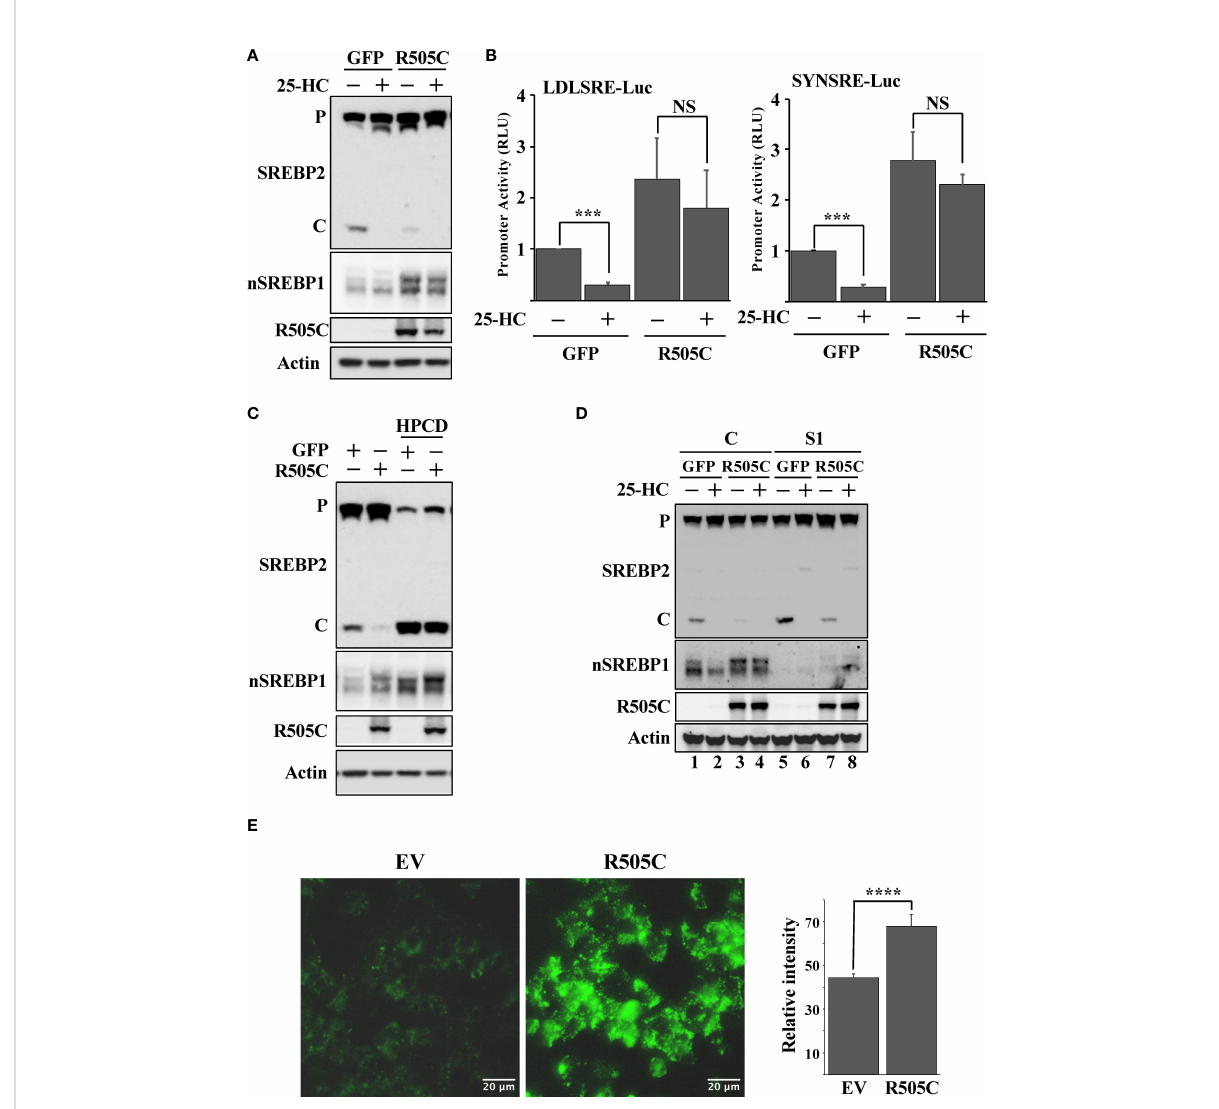
FIGURE 5 Expression of a cancer loss-of-function version of Fbw7 a attenuates the maturation of SREBP2. (A) HepG2 cells were transduced with GFP or mutant Fbw7 a (R505C) and treated without (-) or with ( + ) 25-HC for 6 hours. The levels of SREBP2, nuclear SREBP1 ( nSREBP1 ), mutant Fbw7 a ( R505C ) and b - actin in total lysates were determined by Western blotting. P and C denotes the precursor and cleaved forms of SREBP2, respectively. (B) HepG2 cells were transfected with luciferase promoter-reporter constructs containing the sterol-responsive portions of the human LDL receptor ( LDLRSRE-Luc ) or HMG-CoA synthase ( SYNSRE-Luc ) promoters together with empty vector or mutant Fbw7 a ( R505C ). Where indicated, the transfected cells were treated with 25-HC for the last 3 hours of the experiment. At the end of the experiment, cells were lysed, and luciferase activity was measured. (C) HepG2 cells were transduced with GFP or Fbw7 a (R505C) and left untreated ( - ) or treated ( + ) with HPCD for 2 hours. The levels of SREBP2, nuclear SREBP1 ( nSREBP1 ), mutant Fbw7 a ( R505C ) and b -actin in total lysates were determined by Western blotting. P and C denotes the precursor and cleaved forms of SREBP2, respectively. (D) HepG2 cells were transduced with either GFP or Fbw7 a (R505C), followed by either control ( C ) or SREBP1 ( S1 ) shRNA, and left untreated ( - ) or treated ( + ) with 25-HC for 6 hours. The levels of SREBP2, nuclear SREBP1 ( nSREBP1 ), mutant Fbw7 a ( R505C ), and b -actin in total lysates were determined by Western blotting. (E) HepG2 cells were transduced as in ( D ), fi xed, and stained with LipidTOX Green neutral lipid stain. The mean fl uorescence intensities -/+ SD across each experimental group are provided in the bar graph. P-values lower than 0.05 were considered statistically signi fi cant. *P < 0.05, **P < 0.01, ***P < 0.001, and ****P < 0.0001. NS , not signi fi